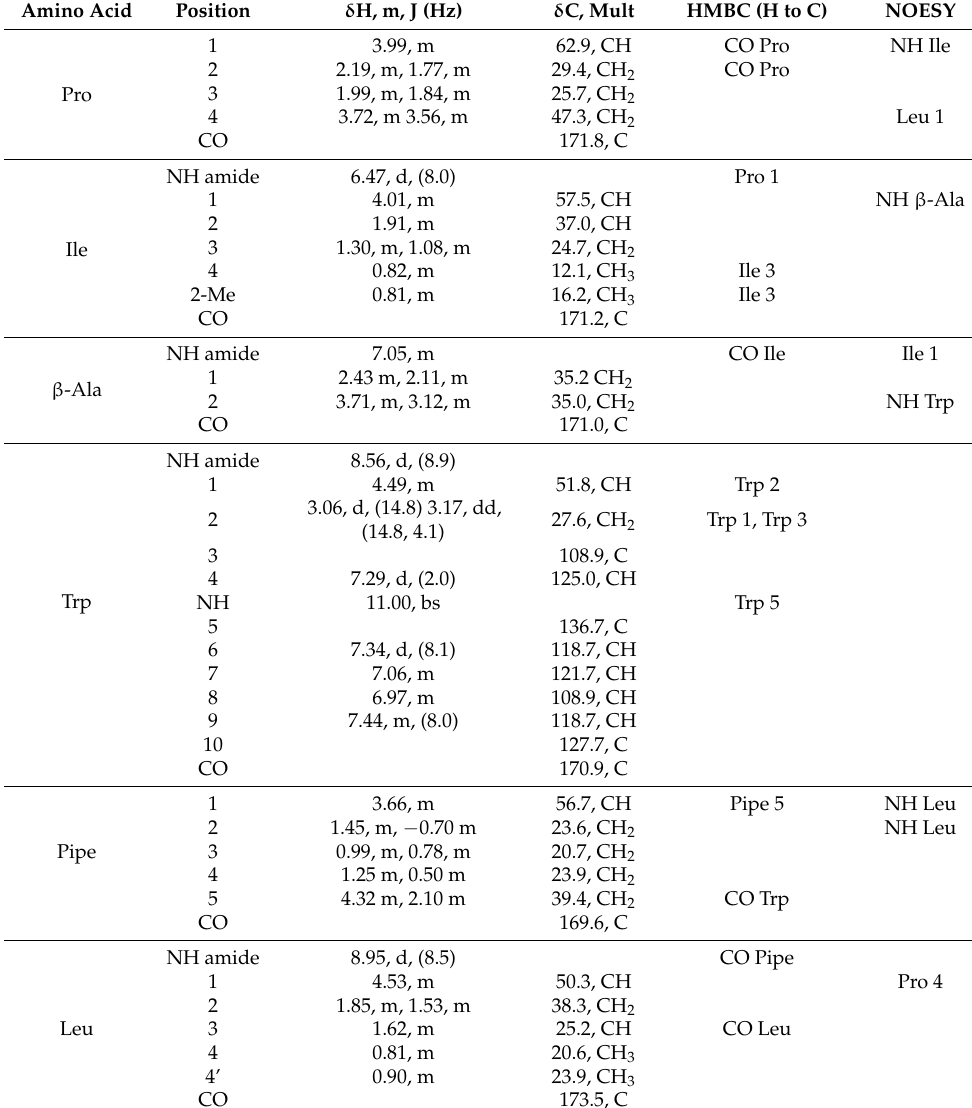
Table 1. NMR data of pipecolisporin ( 1 ) in DMSO- d 6